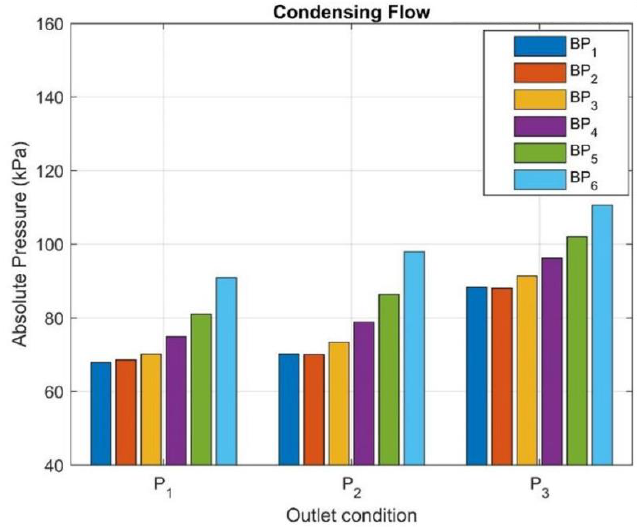
Figure 8. Axial pressure distribution in condensing